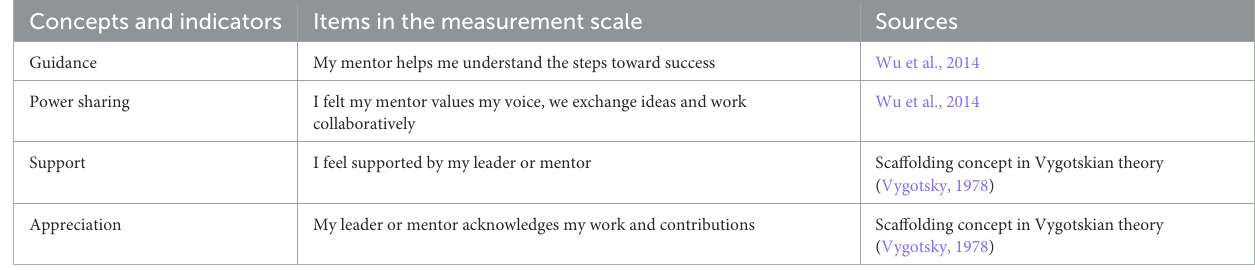
TABLE 3 Nomological network for the construct mentoring experiences: youth-mentor relationship scale.